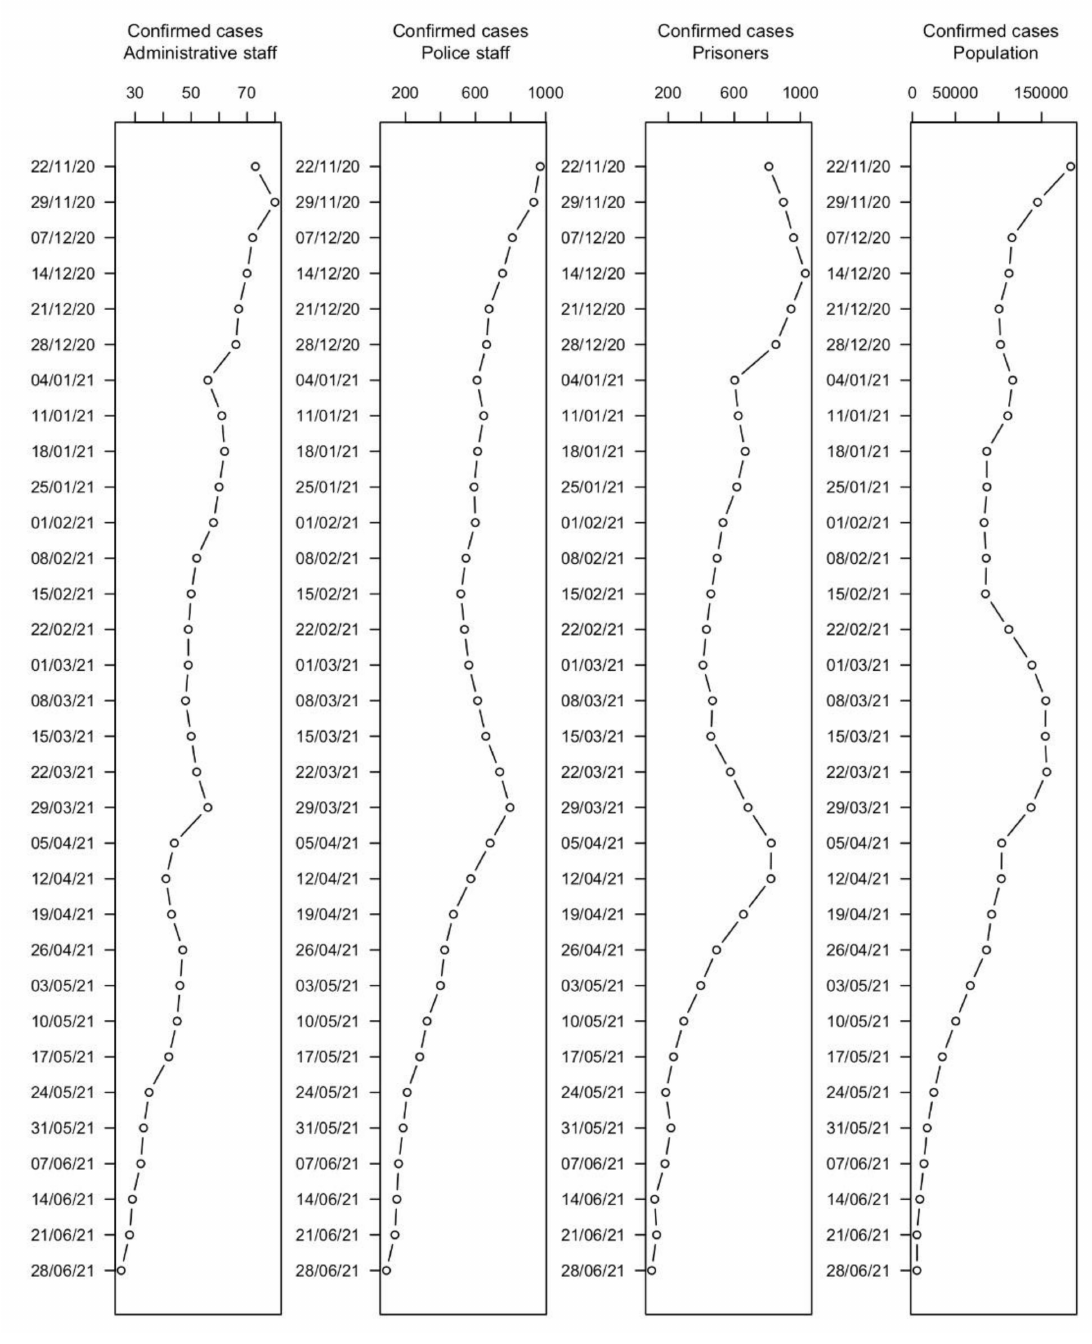
Figure 2. Epidemiological trends of SARS-CoV-2 infection from November 2020 to June 2021: Italian population; prisoners; police staff; and administrative